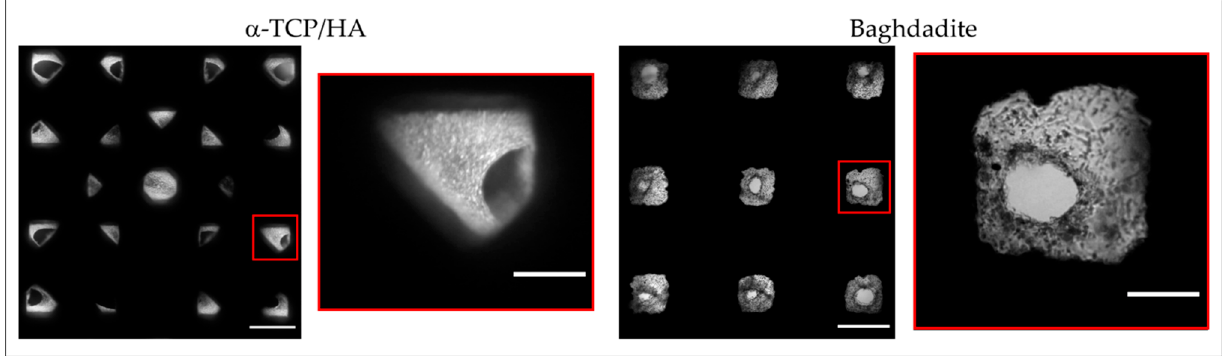
Figure 4. Top view transmitted light microscopy images of α -TCP/HA and baghdadite scaffold with overview images ( left , scale bar: 500 µm) and a magnified representative pore ( right , scale bar: 150 µm). Images were taken after 28 days of cultivation in normal growth medium. The bright regions correspond to adhered MC3T3-E1 cells within the scaffold pores (microscope: Nikon Eclipse TS100; camera: Canon EOS M10, magnification: 4×). The images are representative of five recordings per scaffold.